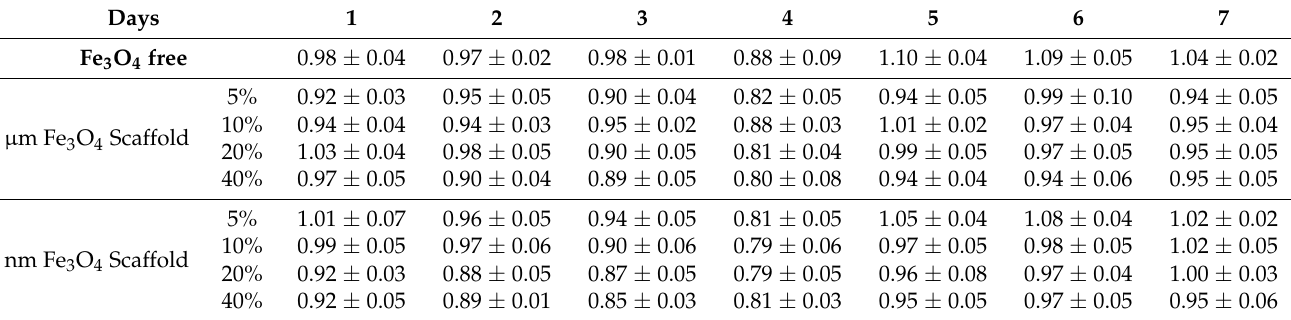
Table 2. Cytotoxicity assay of the prepared magnetic scaffolds as a function of time (day 1–day 7). Tests included micro- and nano-meter sized Fe 3 O 4 at different ratios to PCL.